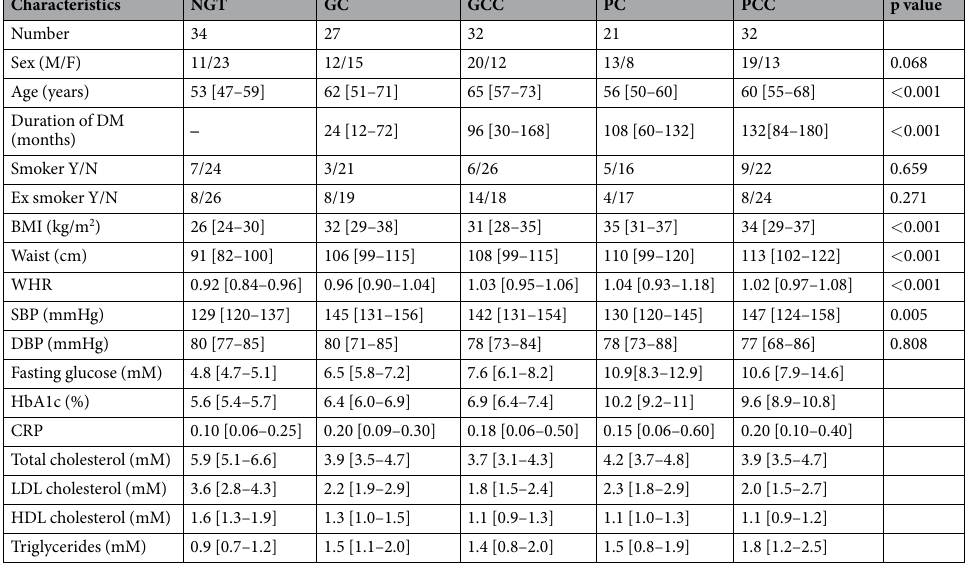
Table 1. Characteristics of Study Participants. Data are expressed as median [Inter quartile range]. BMI, Body Mass Index, SBP, Systolic Blood Pressure, DBP, Diastolic Blood Pressure, WHR, Waist-to-hip ratio Data are expressed as median [Inter quartile range]. p value corresponds to the differences between groups. HbA1c, glycosylated haemoglobin, HDL, high-density lipoprotein, LDL, low-density lipoprotein, CRP, C-reactive